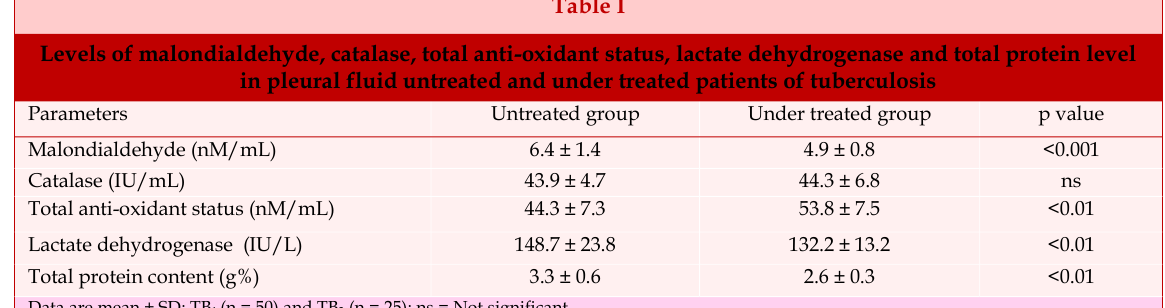
Levels of malondialdehyde, catalase, total anti-oxidant status, lactate dehydrogenase and total protein level in pleural fluid untreated and under treated patients of tuberculosis Parameters Malondialdehyde